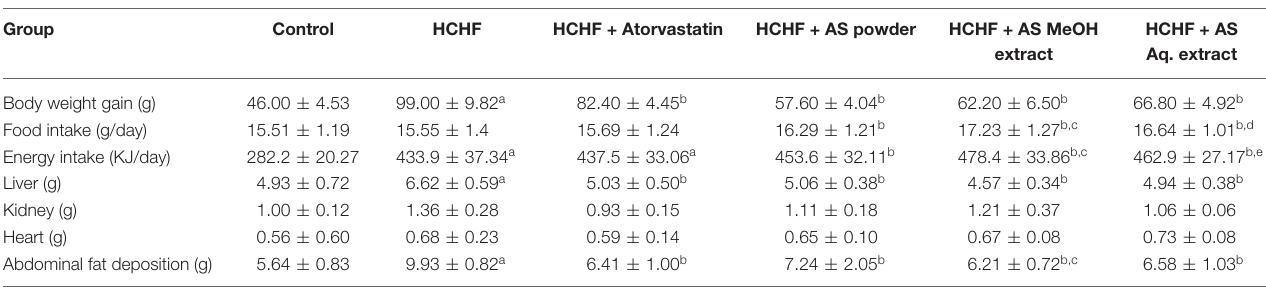
TABLE 1 | Body weight gain, food intake, energy intake, and organ weight variations in experimental groups.